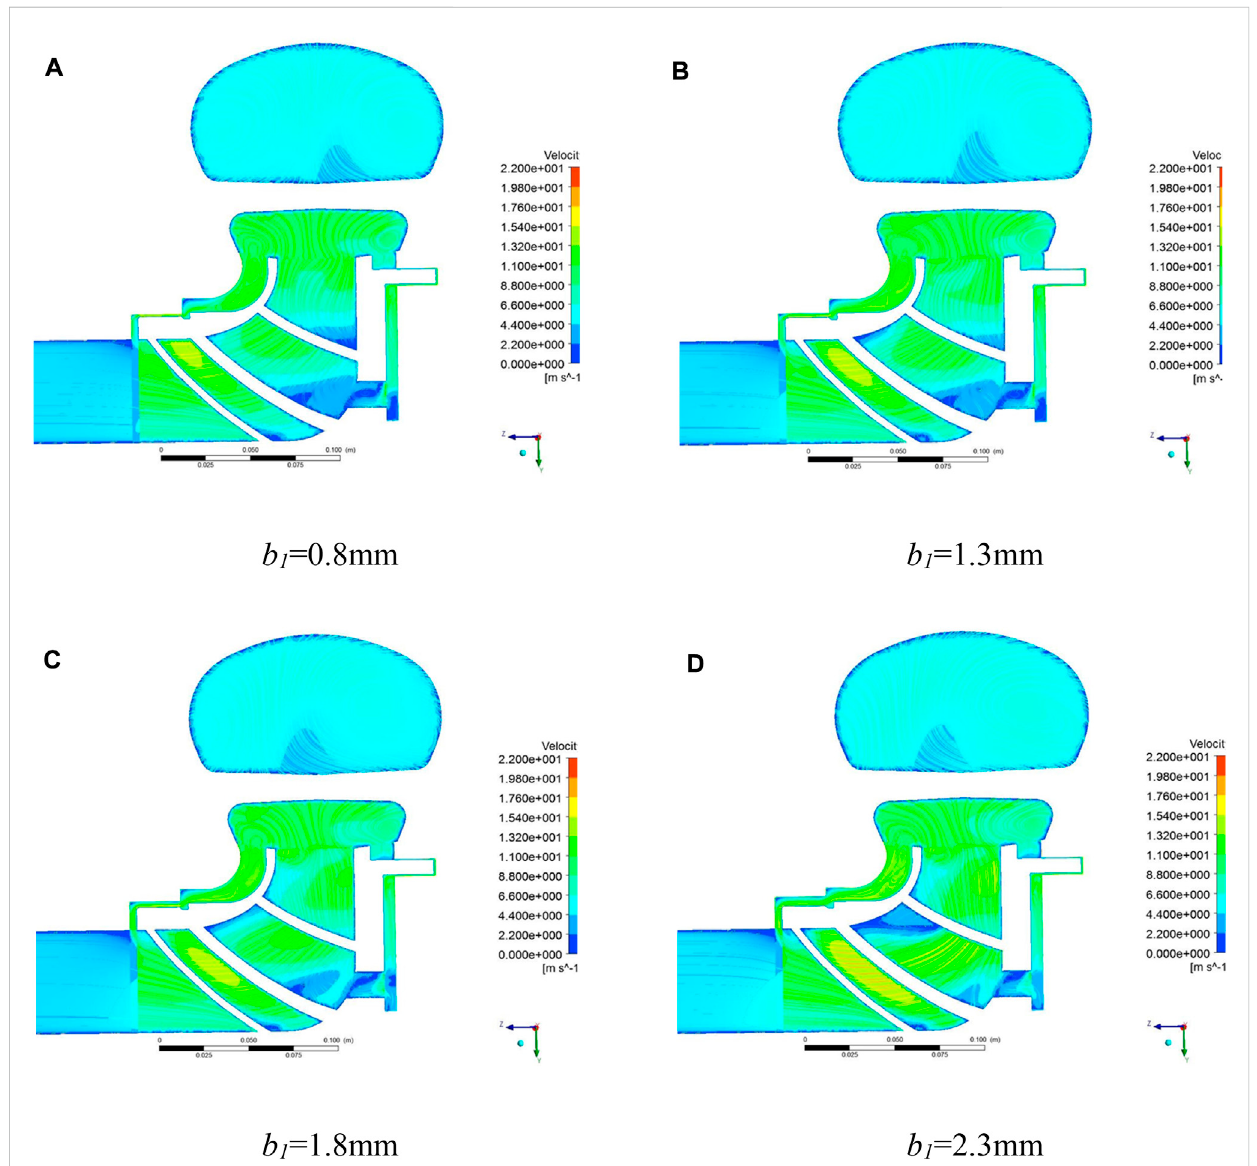
FIGURE 8 TheabsolutevelocitydistributionofX=0sectionunderdifferentclearanceoffrontwear-ring. (A) b 1 =0.8 mm; (B) b 1 =1.3 mm; (C) b 1 =1.8 mm; (D) b 1 = 2.3